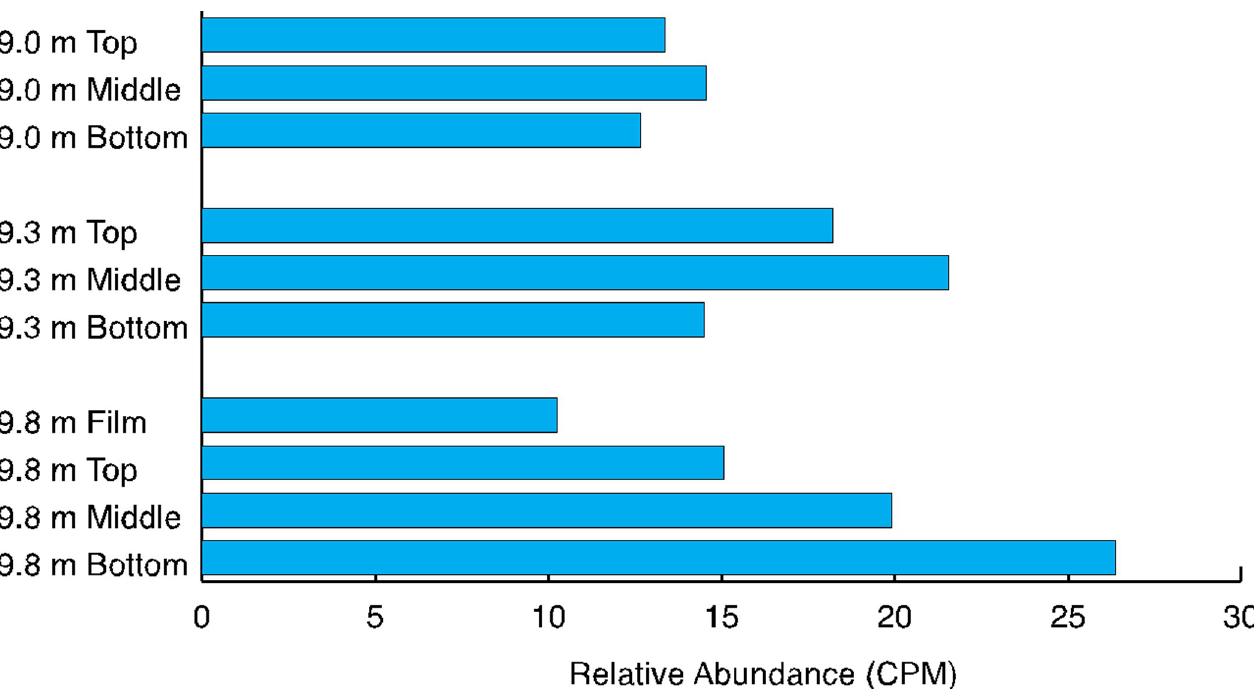
Fig 4. Relative abundance of aerobic respiration capacity. ccoNO as estimated from metagenomic sequence data remains consistently high throughout depths and layers.